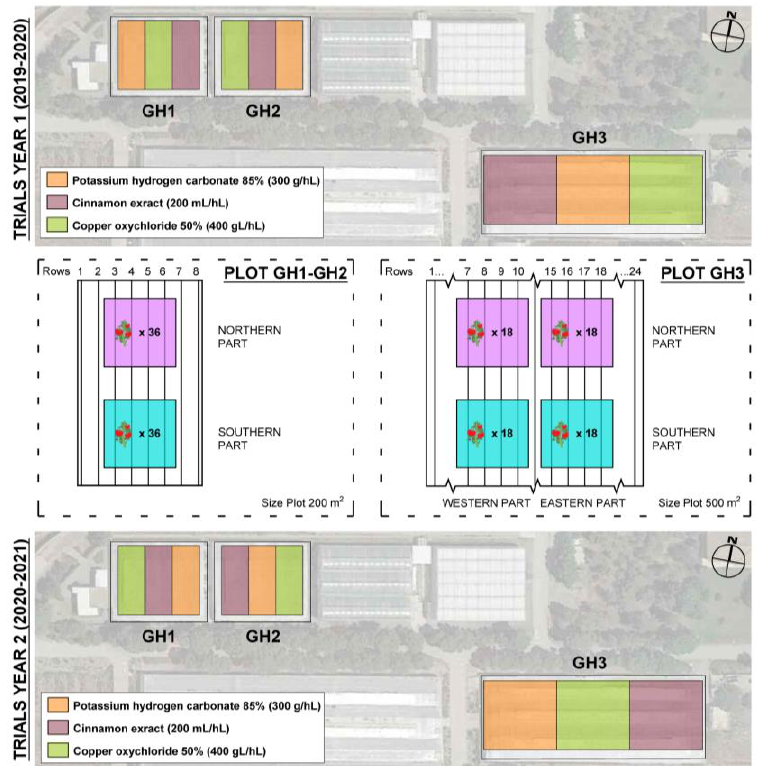
Figure 1. Experimental design and treatments in the seasons 2019/20 and 2020/21 (i.e., Season 1 and Season 2, respectively). The figure shows the distribution of the treatments in each experimental greenhouse (GH) as well as the divisions of the plots (including the number of plants evaluated in each division) that were considered as random replicates and that were thus considered elementary plots.